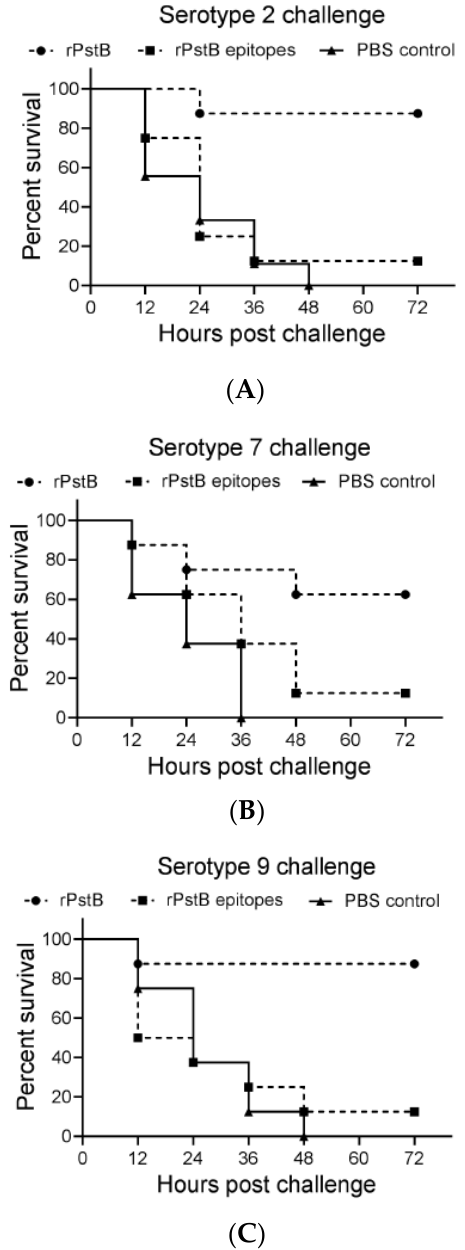
were challenged with a lethal dose of S. suis serotype 2 (ZY05719), 7 (SH04815) or 9 (SH26) strains, respectively, after 10 days post-booster immunization. Death was observed between 12–48 h post- challenge and survival curves were